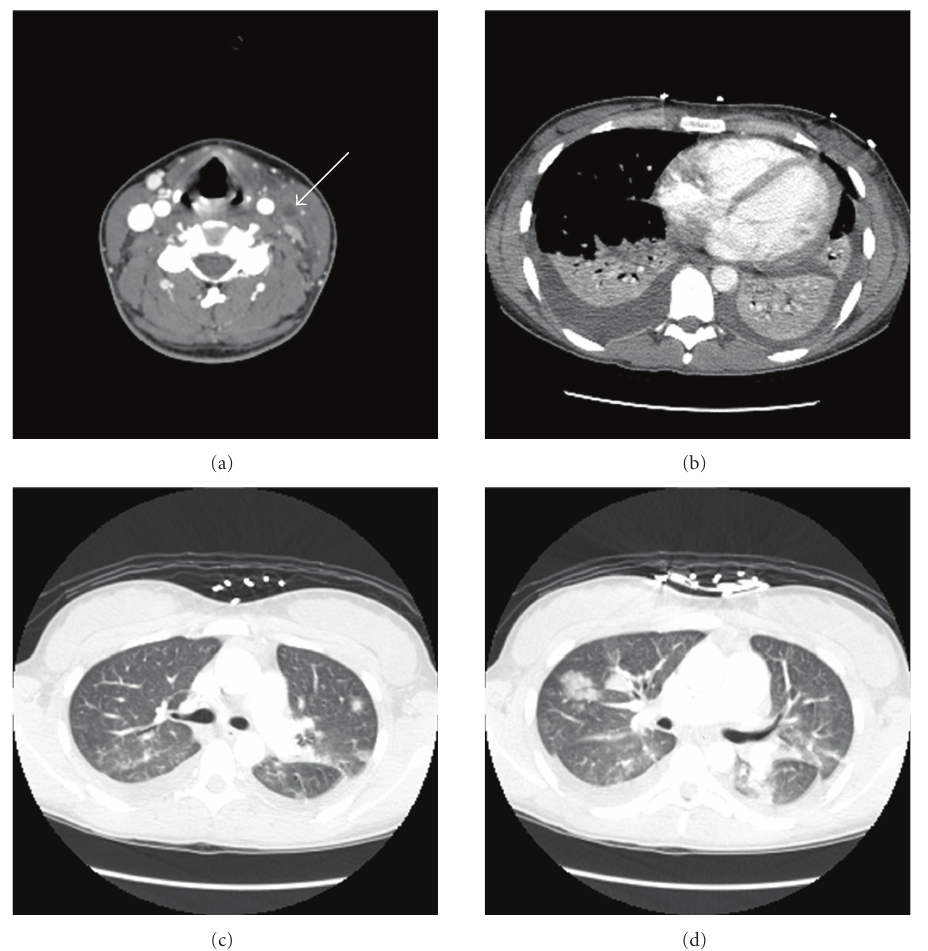
Figure 1: Neck CT scan (a) with contrast reveals left IJV thrombosis noted by the arrow. Chest CT scan reveals bilateral e ff usions (b) and multiple septic emboli (c and